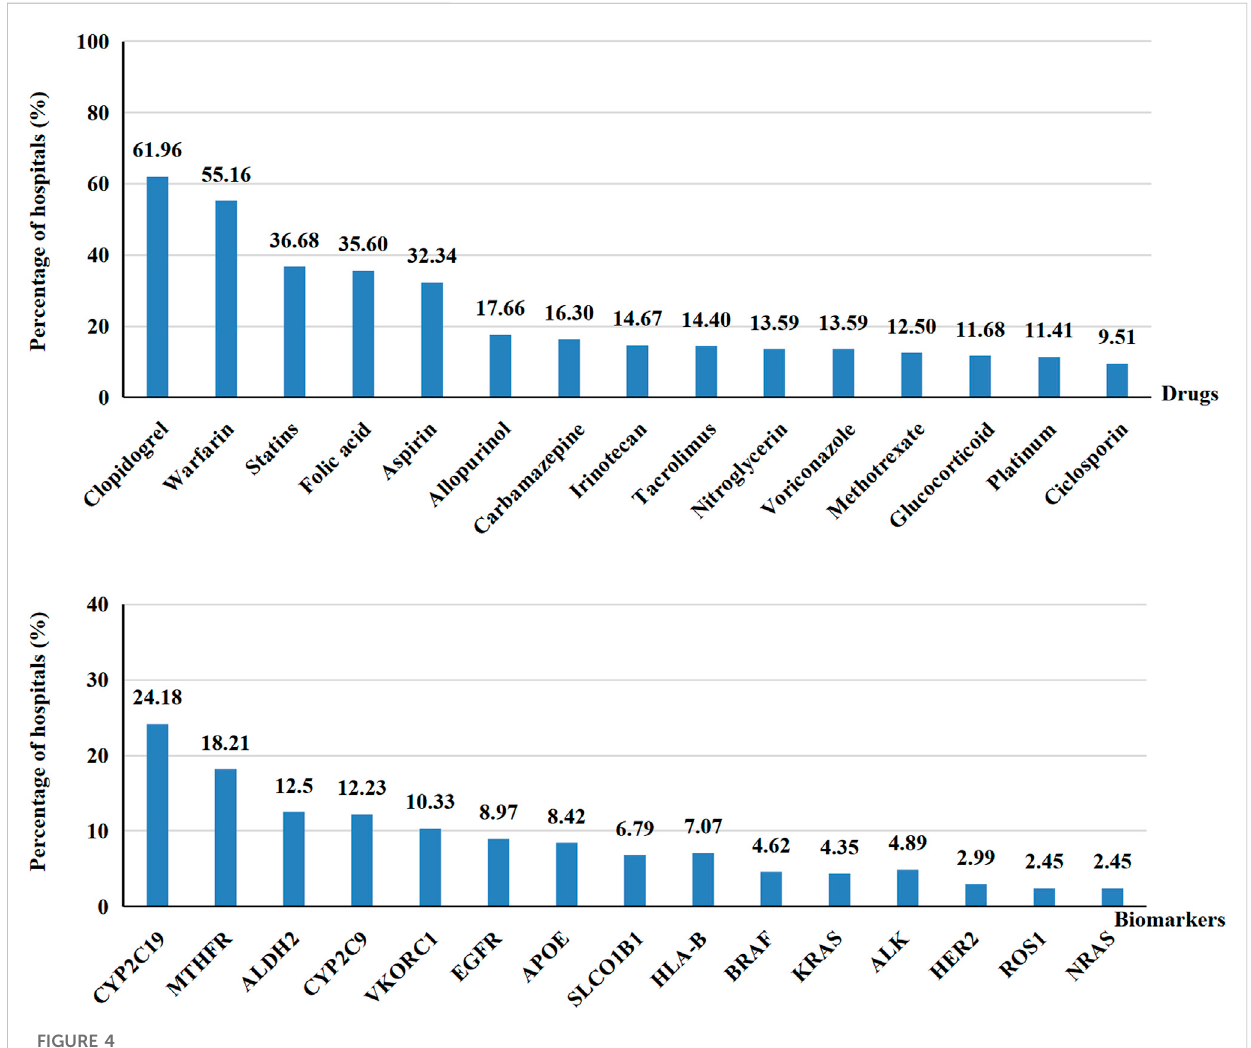
FIGURE 4 The percentage of drugs and genes performed PGx